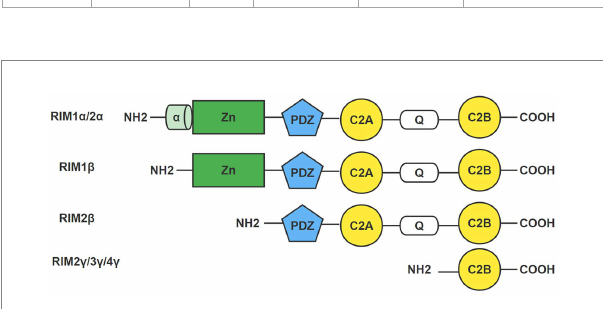
FIGURE 1 Domain of the RIM. RIM is a multidomain protein with an α helically wrapped zinc finger structure, a PDZ domain, two C2 domains at the C-terminal end, and a proline-rich conservative sequence between the two C2 domains from the N-terminus to the C-terminus. The domains of seven RIM isoforms are shown here: RIM1 α /1 β